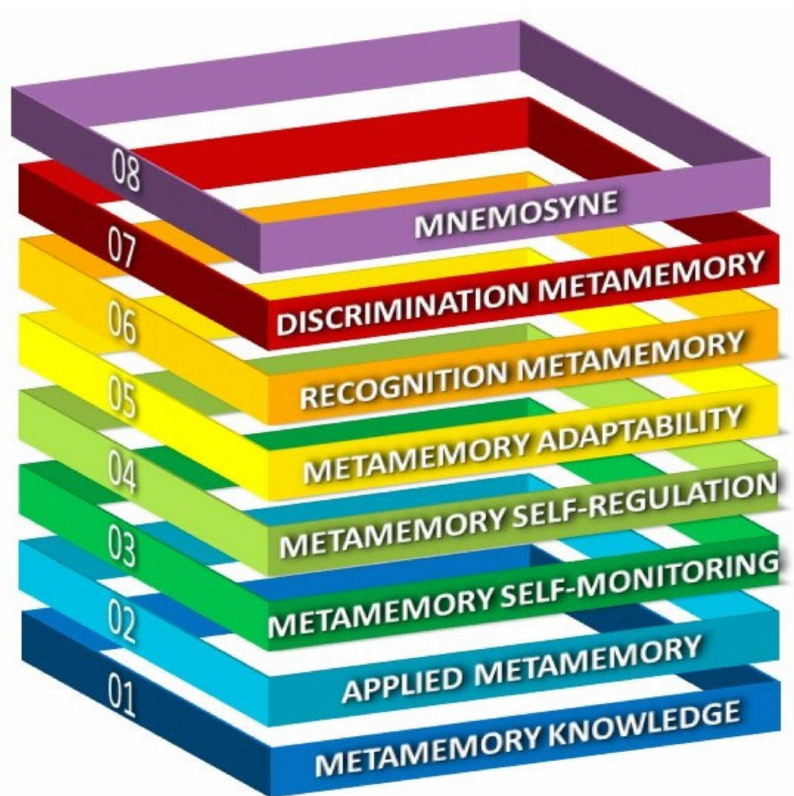
Figure 1. The eight pillars of the metamemory model based on metacognition. The metamemory model consists of eight distinct but complementary